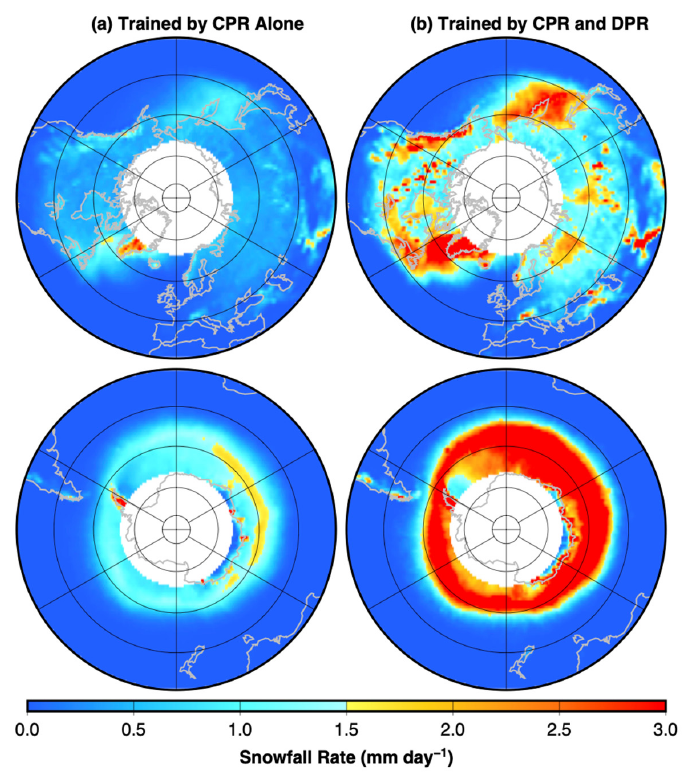
Figure 9. Mean snowfall rate retrieved from 5 years of GMI data using algorithms trained by ( a ) CloudSat CPR alone and ( b ) combined CloudSat CPR and GPM DPR. ( a ) CloudSat CPR alone and ( b ) combined CloudSat CPR and GPM